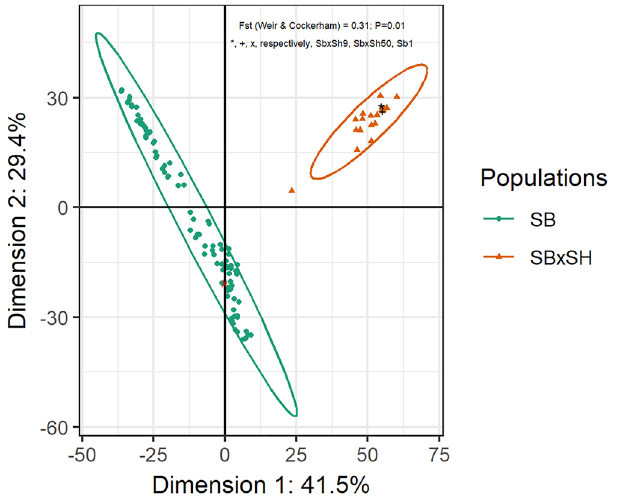
Figure 1. Genetic differentiation analysis in Sb and SbxSh populations. The ellipses are drawn accounting for the 95% confidence interval and the Euclidean distance from the center “o”. Genotypes outside the ellipses are outliers 74 .